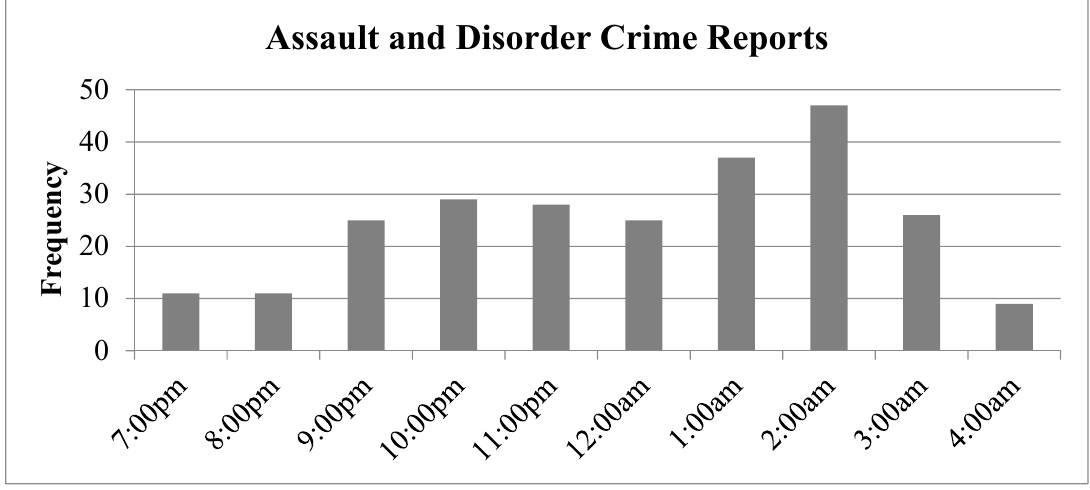
Figure 2. Frequency of violent and disorder crime reports between 7:00 p.m. and 4:00 a.m., Friday